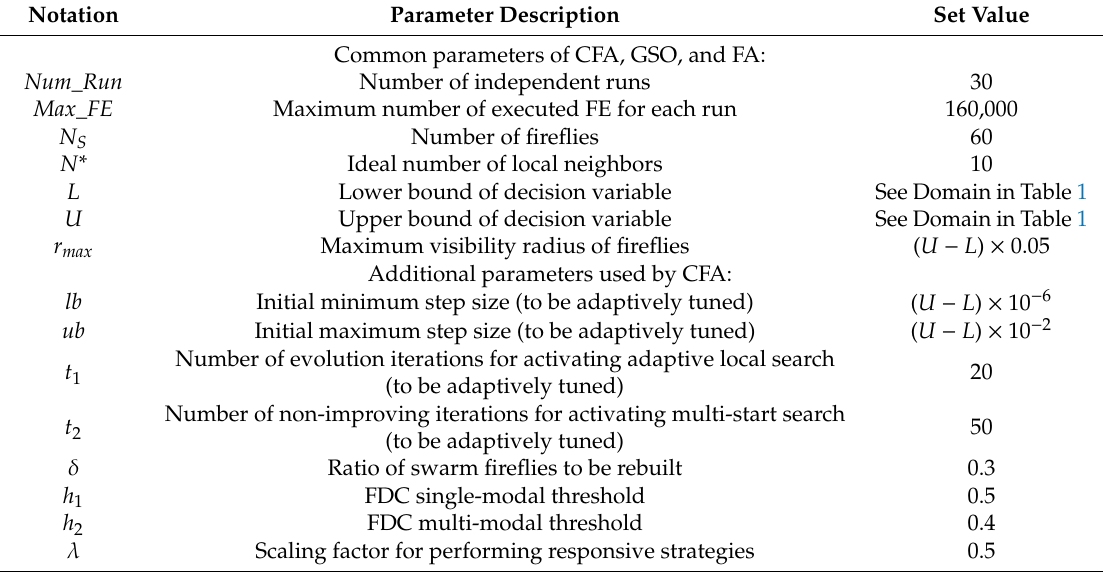
Table 2. Parameter settings of the CFA, GSO, and